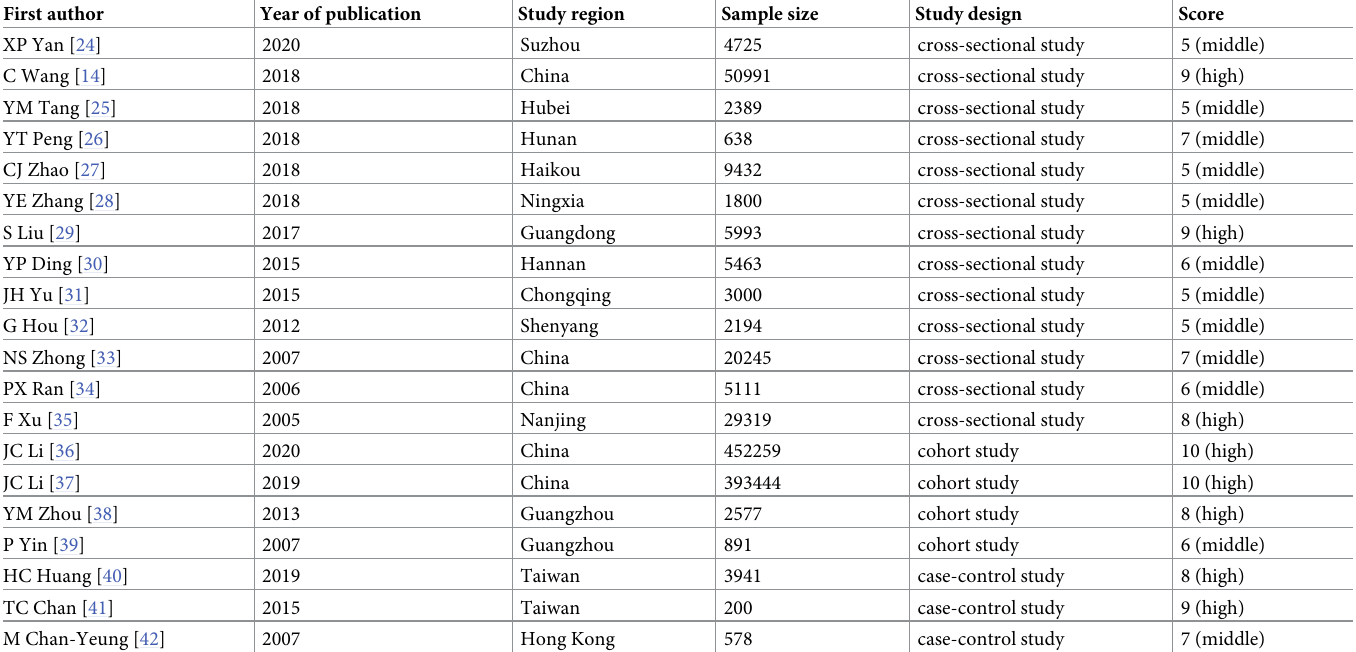
Table 1. Characteristics of included trials and methodological quality assessments.